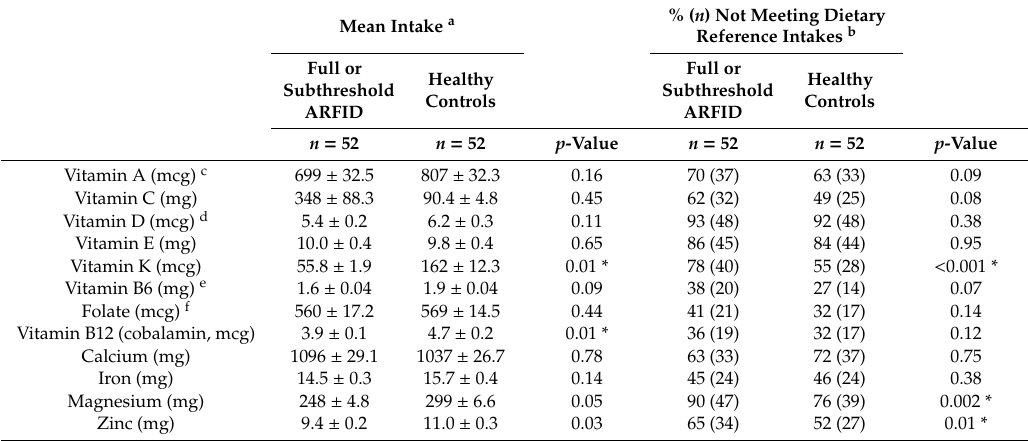
Table 6. Micronutrient intake including fat-soluble vitamins, water-soluble vitamins, minerals, and trace minerals in participants with full or subthreshold ARFID and healthy